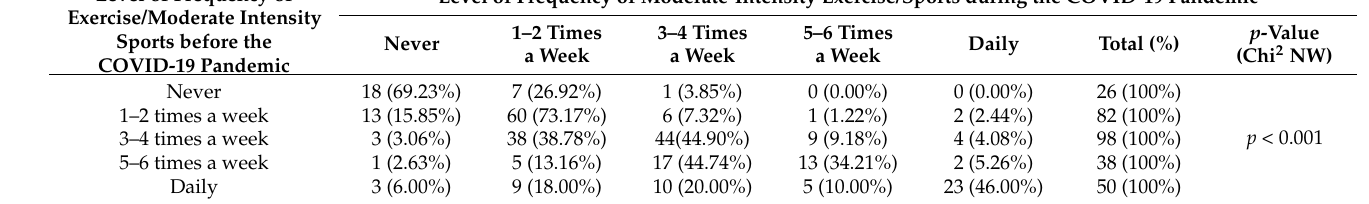
Table 5. Level of frequency of moderate-intensity exercise/sports before and during the COVID-19 pandemic.